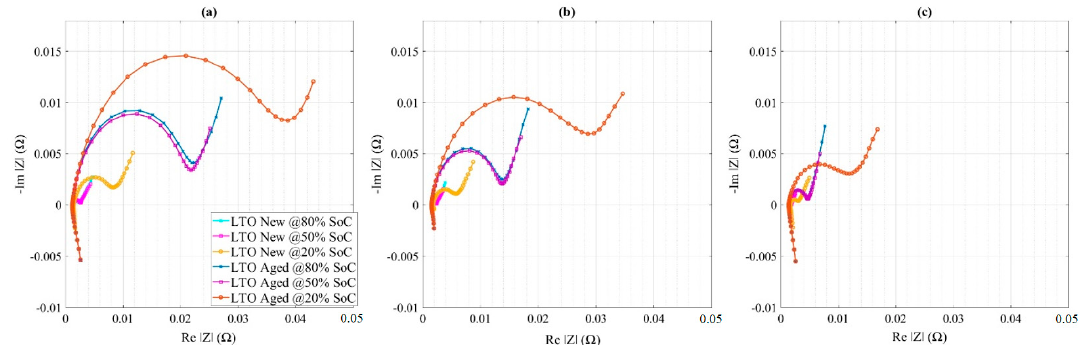
Figure 12. Nyquist plots for new and aged LTO cells at ( a ) 15 °C, ( b ) 25 °C, and ( c ) 45 °C.